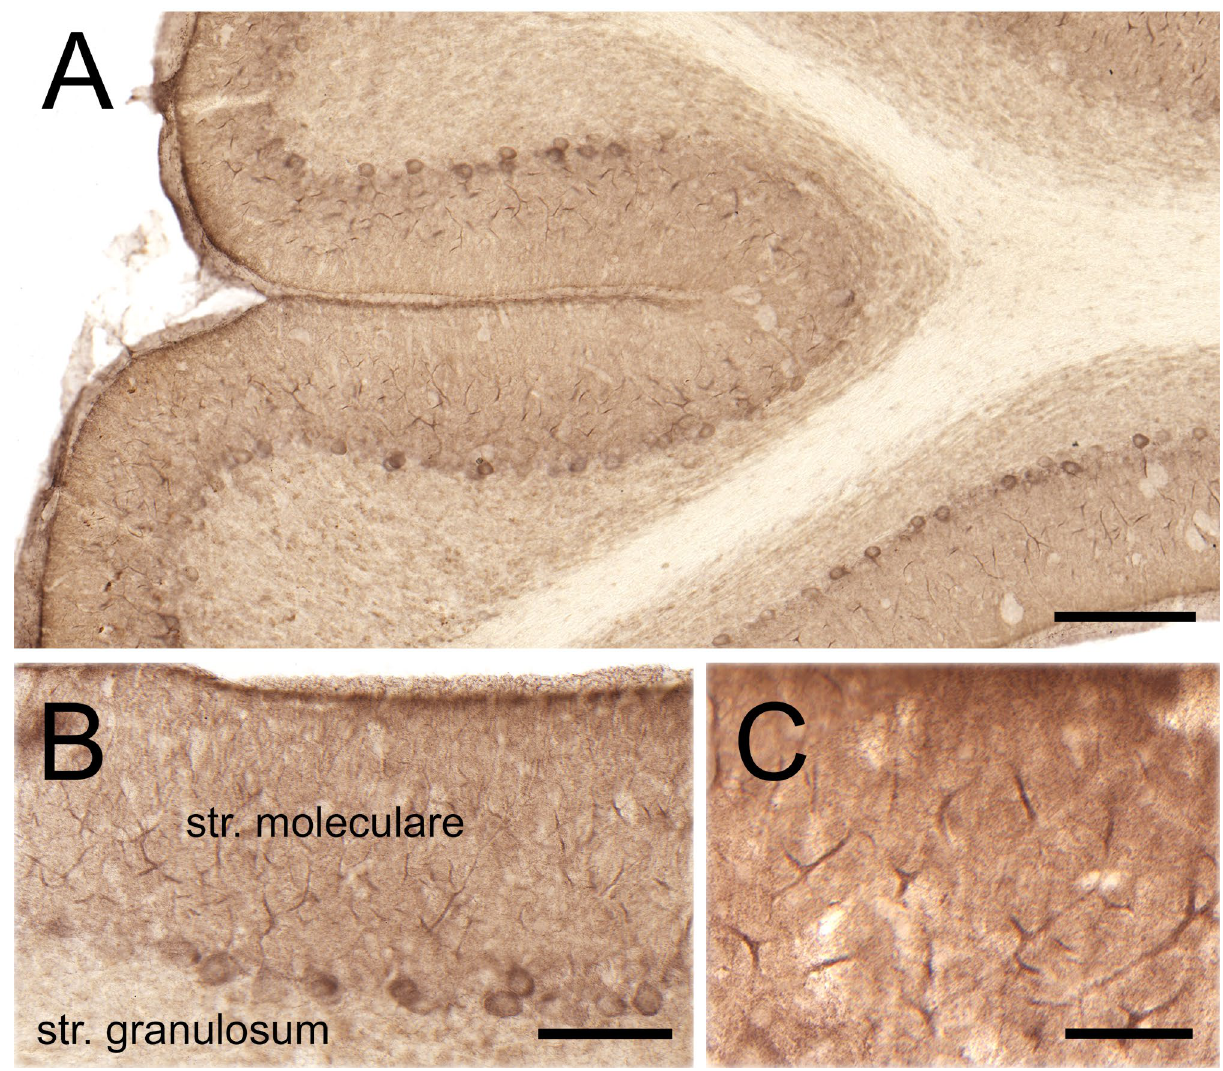
Figure 1. Immunoperoxidase staining for cortactin in cerebellum. (A) Low magnification view of cerebellar cortex. ( B) The three layers of the cortex can be seen: inner layer: str. granulosum, Purkinje-cell layer in the middle, outer layer: str. moleculare. Purkinje cell bodies can be seen at the border between str. granulosum and str. moleculare. ( C) Staining is conspicuous within the dendritic arbor of PCs in str.moleculare. Scale bars: (A) : 200 µm, (B) : 100 µm, (C) : 50 distribution (-41 ± 8 nm for synaptophysin and 6 ± 1.5 nm for PSD-95 (n = 110 particles for both proteins), respectively; Fig. 5B). Next, we investigated particle positions outside the PSD-defined synaptic membrane area. By measuring radial particle distances to the non-synaptic spine membrane, we can reveal whether cortactin is restricted to or accumulated in any spinoplasm domain. In this case, we did not consider particles lying within the wedge defined by the lateral edges of the PSD and the geometric center of the spine, in order to avoid bias because of the synaptic cortactin pool (see gray-shaded area in inset in Fig. 5C). We found that these particles were on average at 55 ± 3 nm from the non-synaptic membrane and they were virtually absent from the spine core beyond 200 nm from the membrane (Fig. 5C, n = 130 gold particles). Spine profiles had areas in the range of 0.01–0.2 µm 2 and diameters of 300–600 nm (Table 2). Part of this apparent decline in labeling arises simply because many spine profiles had radii less than 200 nm. We computed a normalized position to correct for this with 0 correspond- ing to a particle at the plasma membrane, and 1.0 to a particle at the geometric center of the spine (see inset in Fig. 5D). This normalization allowed us to plot distribution independent of spine size. Distance bins close to the center of the spine contain much less cytoplasmic area than those close to the membrane. Therefore, the number of particles close to the membrane would be higher than in the center of the spine even for uniformly distributed random points. We computed normalized labeling density to compensate for this reduction in bin area close to the center of the spine by dividing the number of counts in each bin by the normalized radius of the bin. After these corrections, the shell region was found to be highly concentrated in particles coding for cortactin with ~ 0.2 normalized units from the membrane (mean 0.26 ± 0.01 normalized